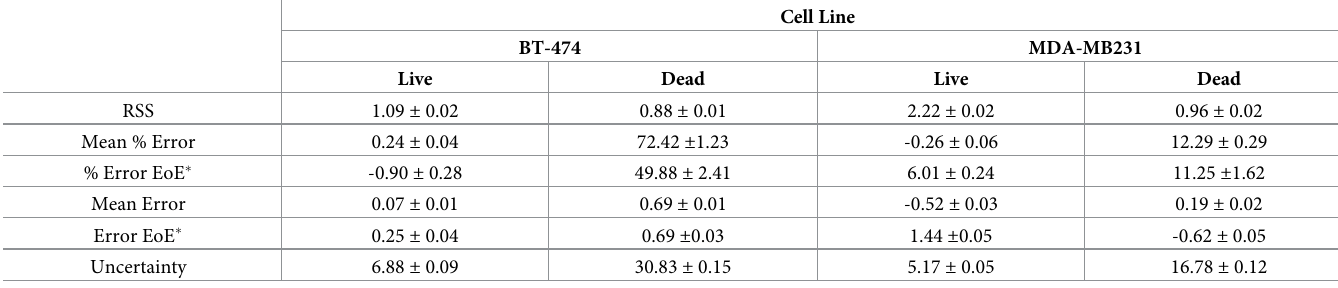
Table 5. Summary of model calibration across 50 training sets.